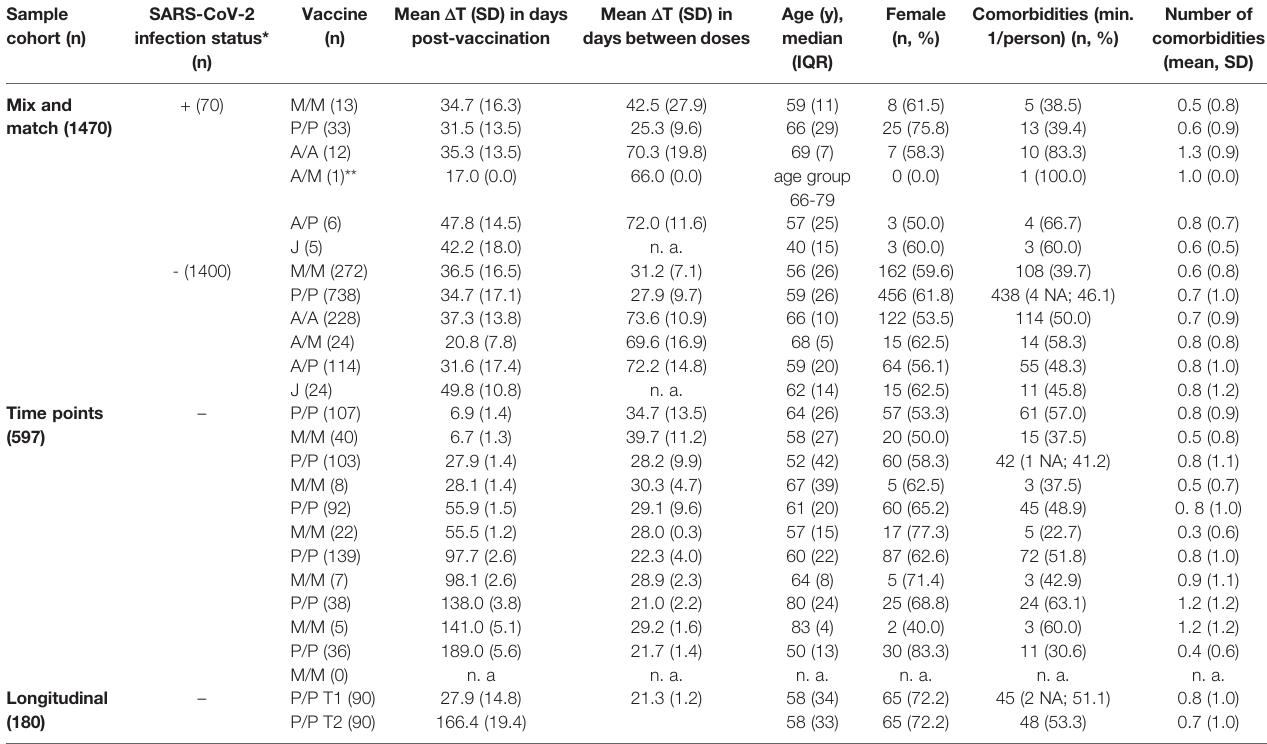
TABLE 1 | Demographics of study population (n. a., not applicable; NA, not